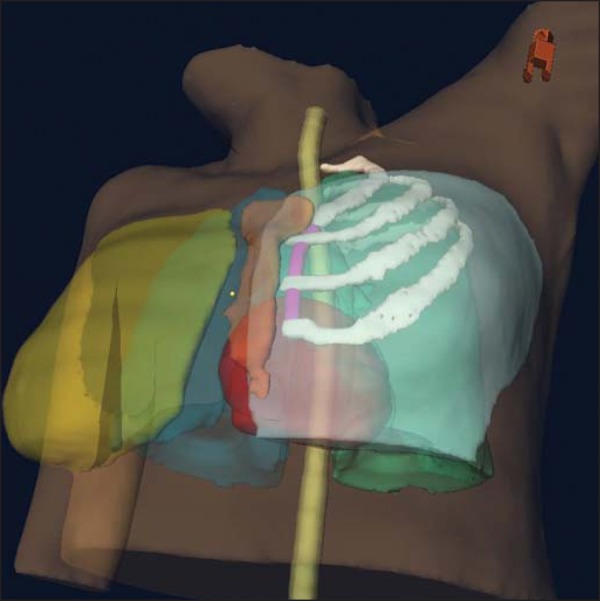
Internal mammary lymph node volume (pink): first, second, and third
intercostal spaces.